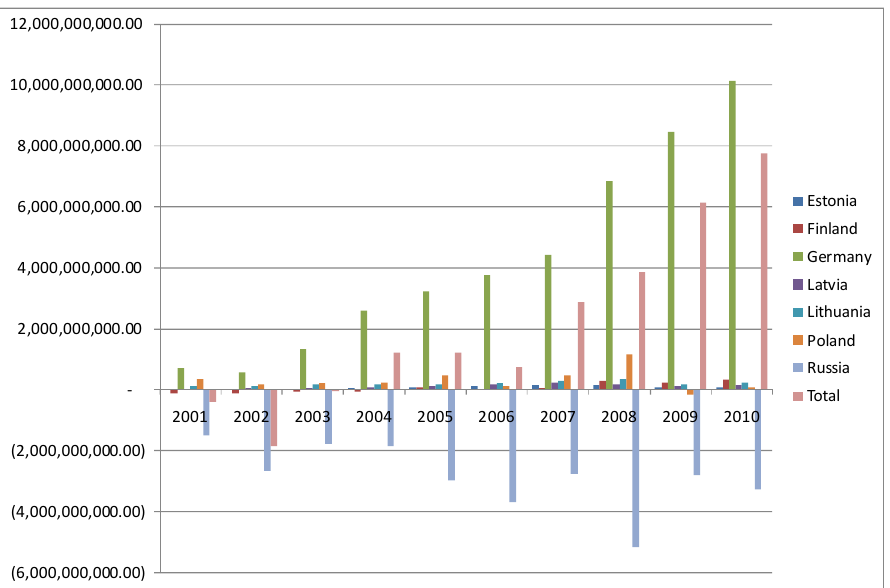
Figure 7 Czech Republic and trade surplus-deficit development with Rail Baltica countries and in total during years 2001-2010 (currency used USD). Source for data: United Nations (2011)